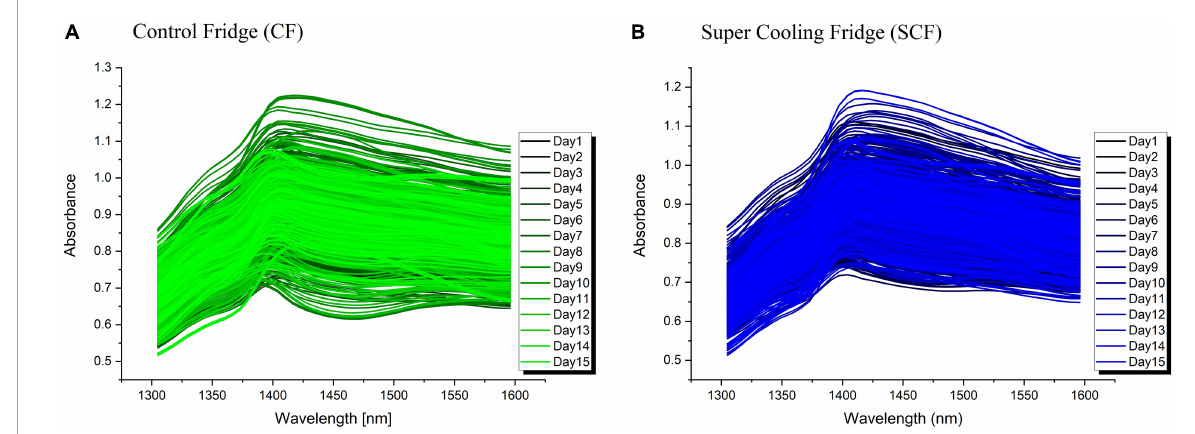
All peaks that were found in the analysis so far are located within the first overtone of water symmetric and asymmetric stretching vibrations, and with the exception of 1,534 nm, all